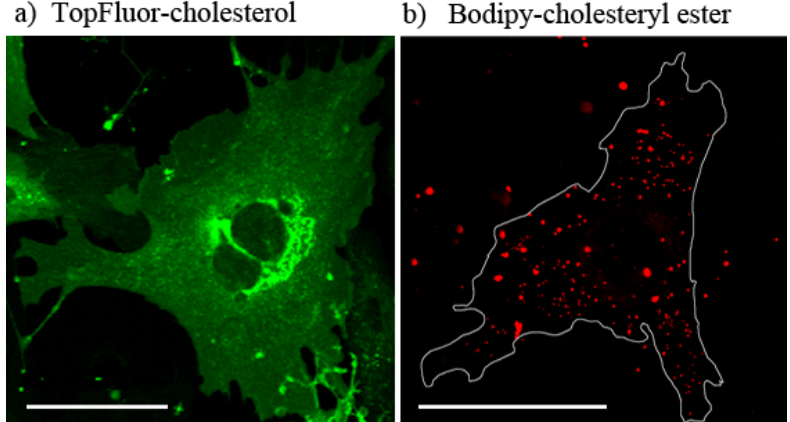
(a) TopFluor-cholesterol delivered by fusogenic liposomes was localized in the plasma membrane, endocytic recycling compartments, Golgi apparatus and endoplasmic reticulum of rat embryonic cardiac fibroblasts 1 h after intercalation; (b) Bodipy-cholesteryl ester was first delivered to the cellular plasma membrane but immediately after incorporation it was transported from the